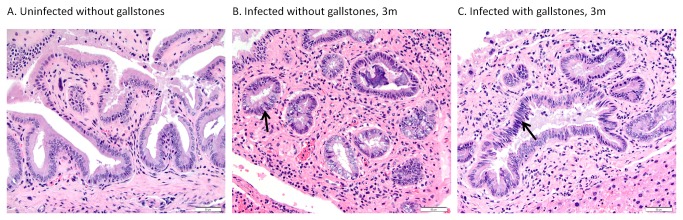
Atypical hyperplasia in the absence of marked necrosuppurative inflammation and/or epithelial hyalinosis was observed in the gallbladder of infected mice, regardless of the presence of gallstones.Representative HE images of gallbladder 3 months post-infection. Black arrows indicate tall columnar biliary epithelial cells with large crowded, basophilic to vesicular nuclei and loss of polarity.40x.